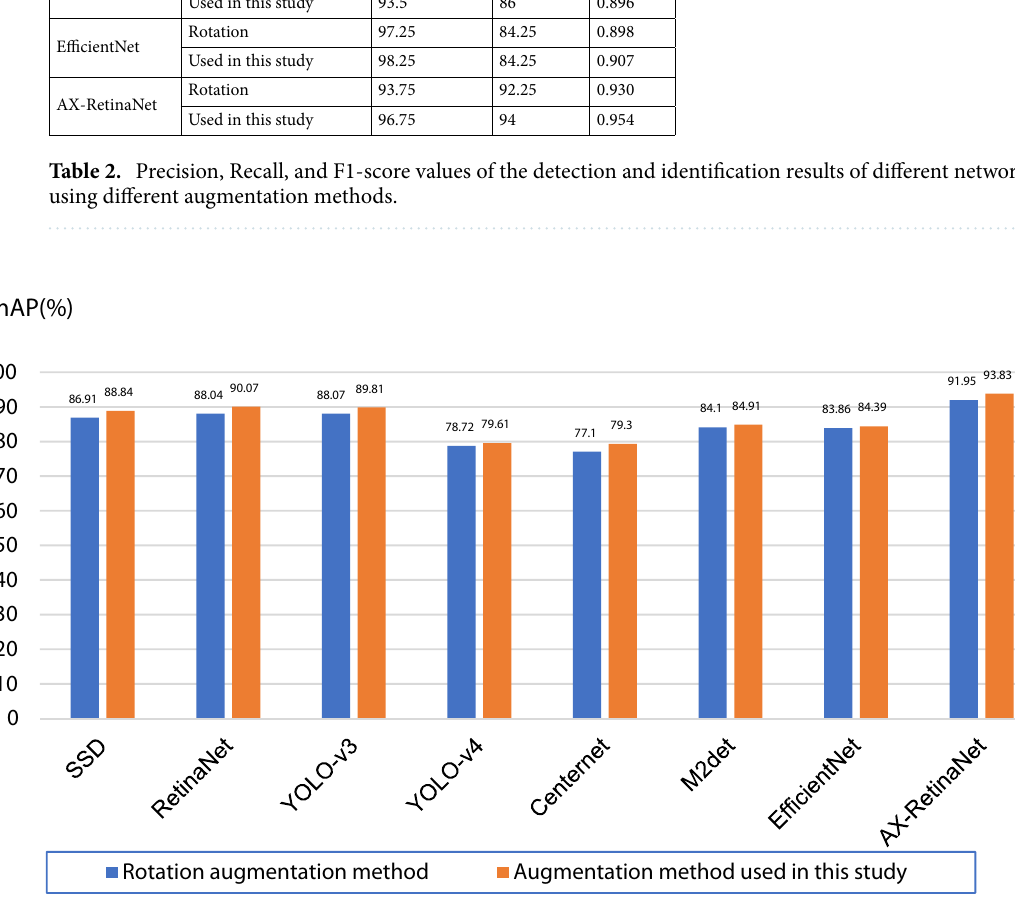
Figure 13. mAP values of the detection and identification results of different networks using different augmentation methods.